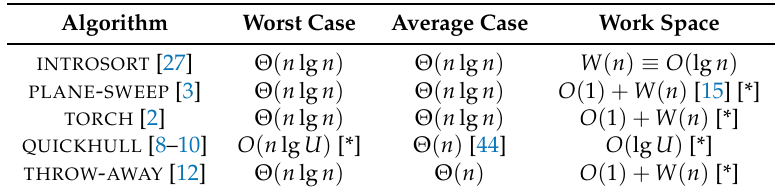
Table 4. A summary of the theoretical performance of the algorithms considered. The average-case running time is for the square data set. Here n denotes the size of the input, U the size of the coordinate universe, and W ( n ) the amount of the work space required by the sorting routine in use. [*] means that the result was presented in this